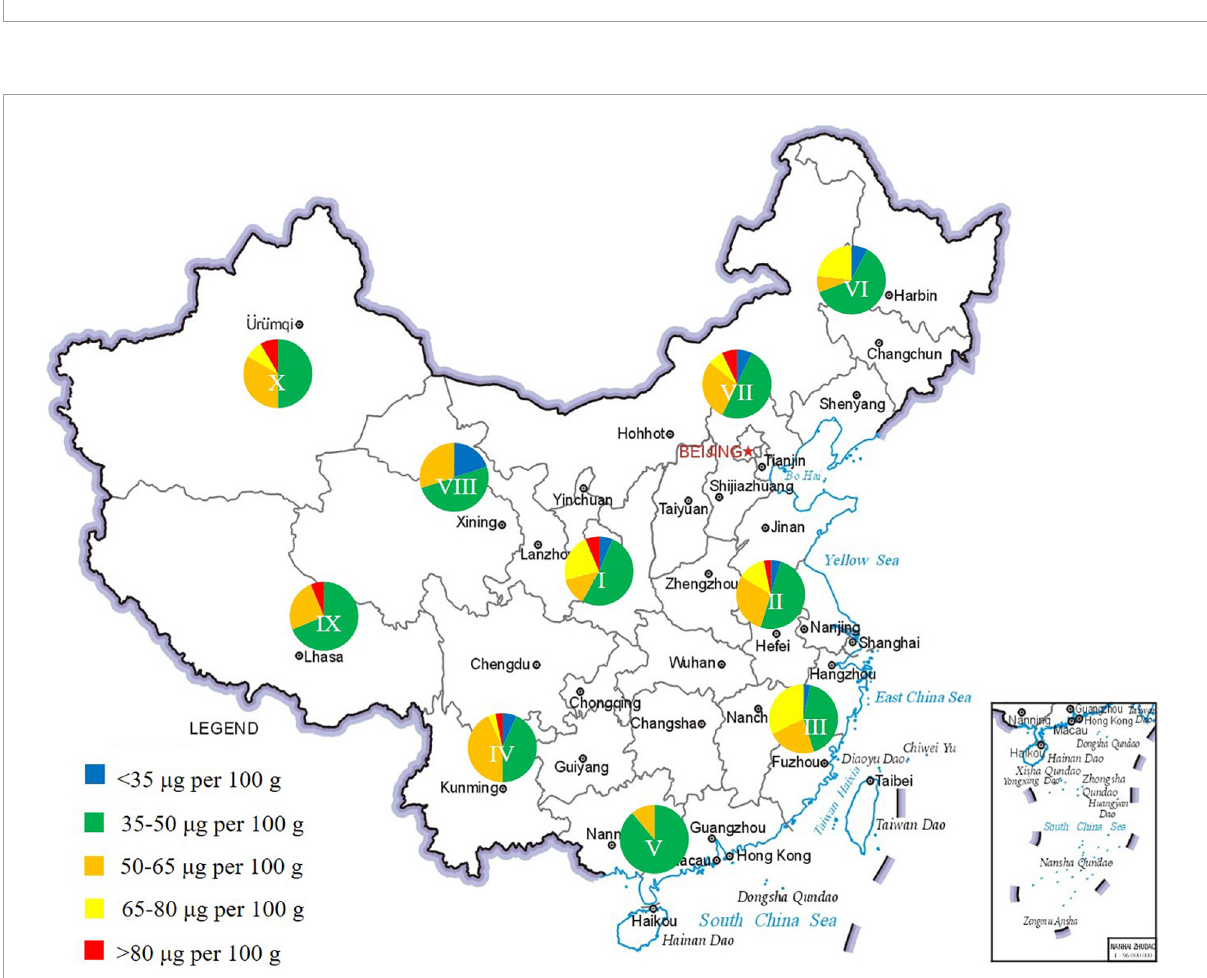
FIGURE2 Frequency distribution of folate contents in agro-ecological production